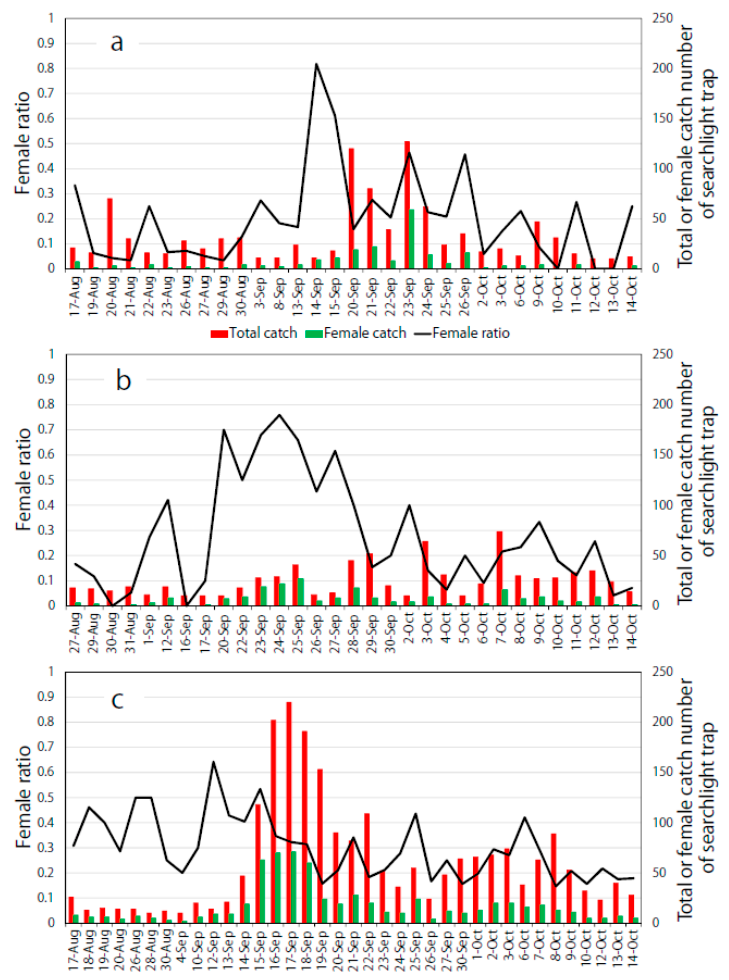
Figure 8. Ratio of S. litura females caught by the searchlight trap in ( a ) 2016, ( b ) 2017, and ( c ) 2018 in Saga Prefecture,